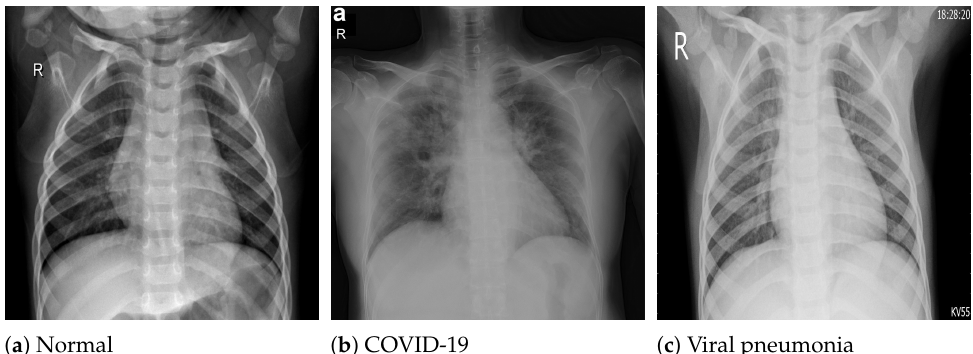
Figure 1. Sample X-ray images from the used